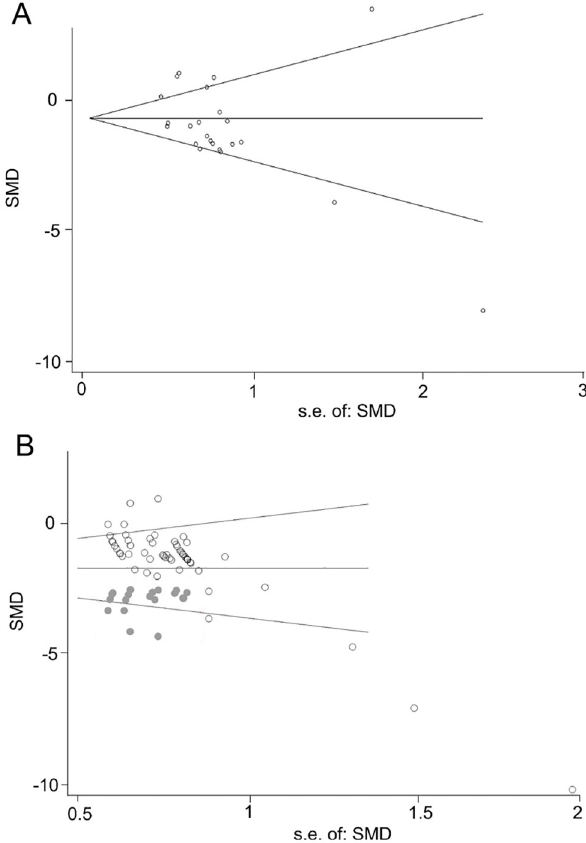
Fig 3. Publication bias. (A, B) Funnel plots. Gray points in (B) represent theoretically missing comparisons identified using the trim-and-fill method.